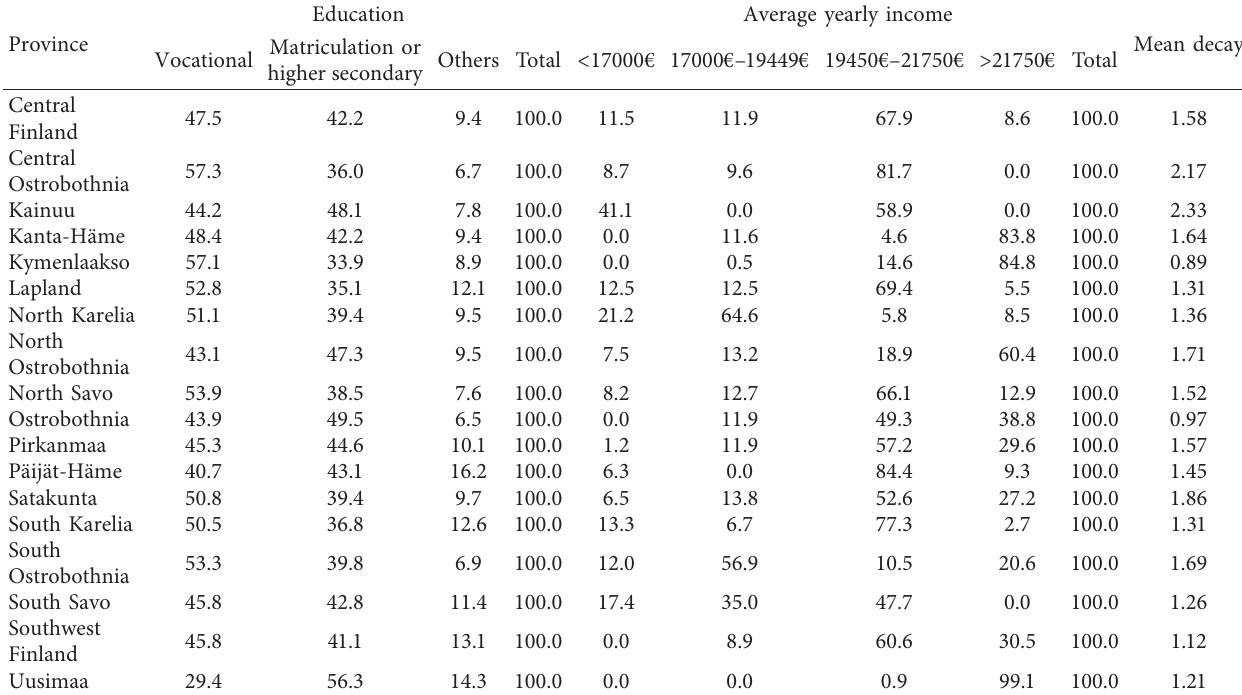
Table 1: Distribution of study participants based on their education background and the average annual income of the municipality and mean tooth decay in the province level.